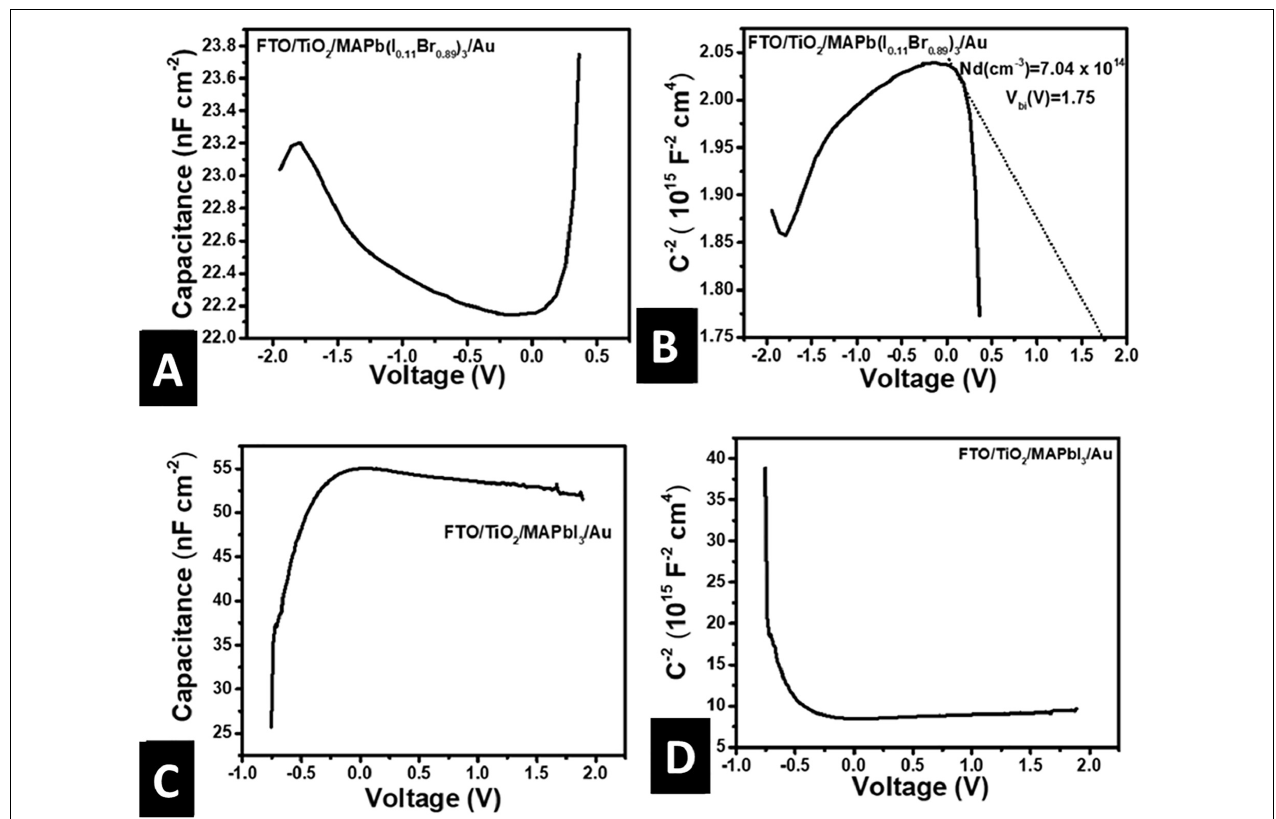
FIGURE 6 | Dark current-voltage, capacitance-voltage and Mott-Schottky plots for FTO/c-TiO 2 /m-TiO 2 /MAPb(I 1 − x Br x ) 3 /Au solar cell. (A) Linear plot current density vs. voltage at forward and reverse bias showing barrier the potential, (B) semi-log plot of current vs. voltage, (C) linear plot of capacitance per unit area vs. voltage, (D) Mott-Schottky plot of inverse square capacitances per unit area vs.